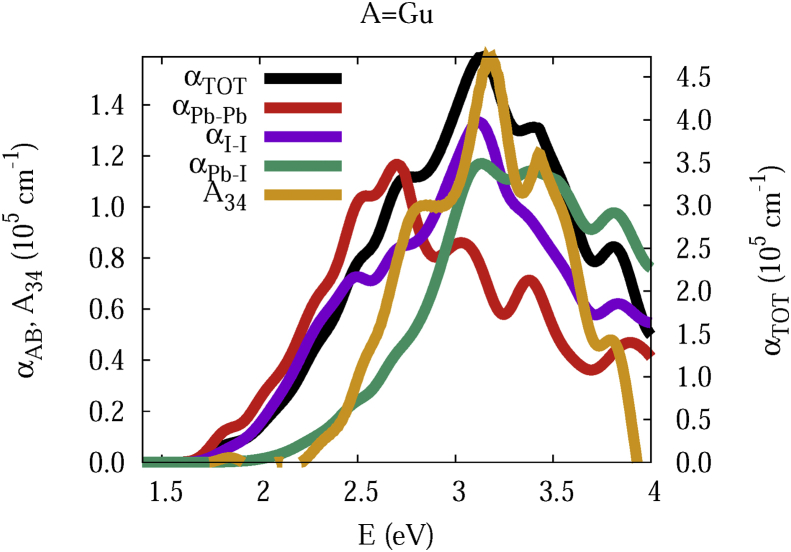
Same legend as that in Fig. 1, but for A = Gu.